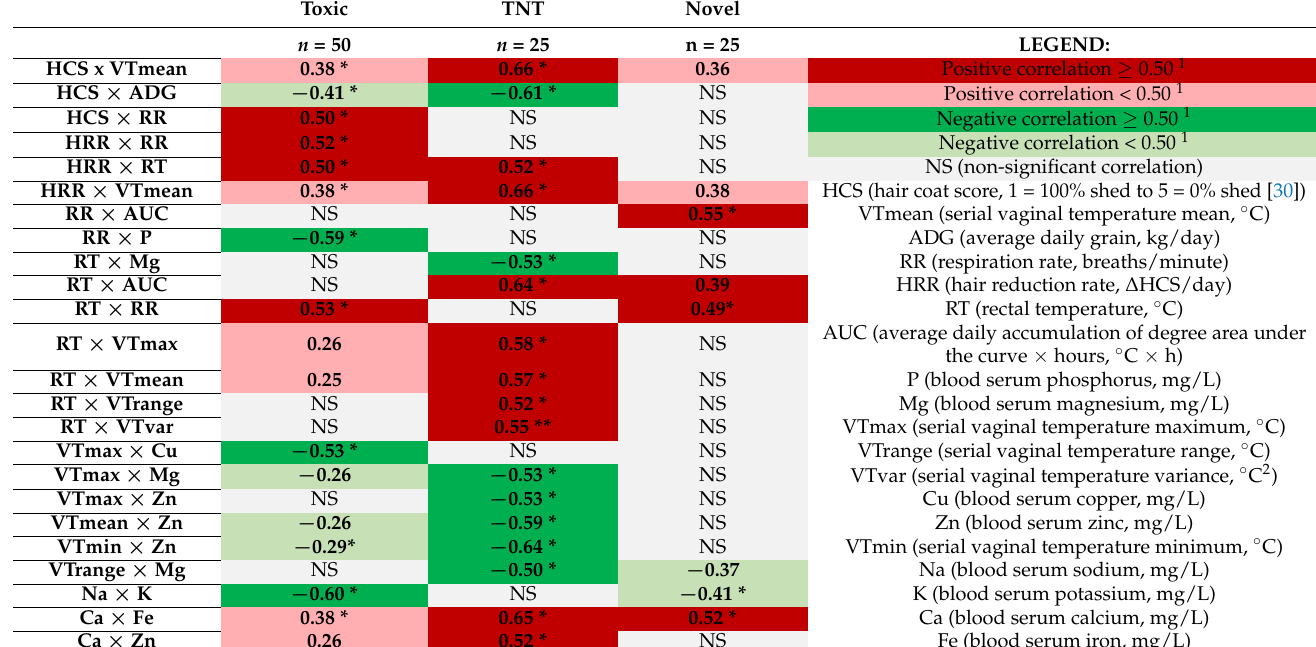
Table 4. Pearson’s correlation among heat stress and fescue toxicosis phenotypes contrasted by fescue treatment 1,2 . Toxic TNT Novel